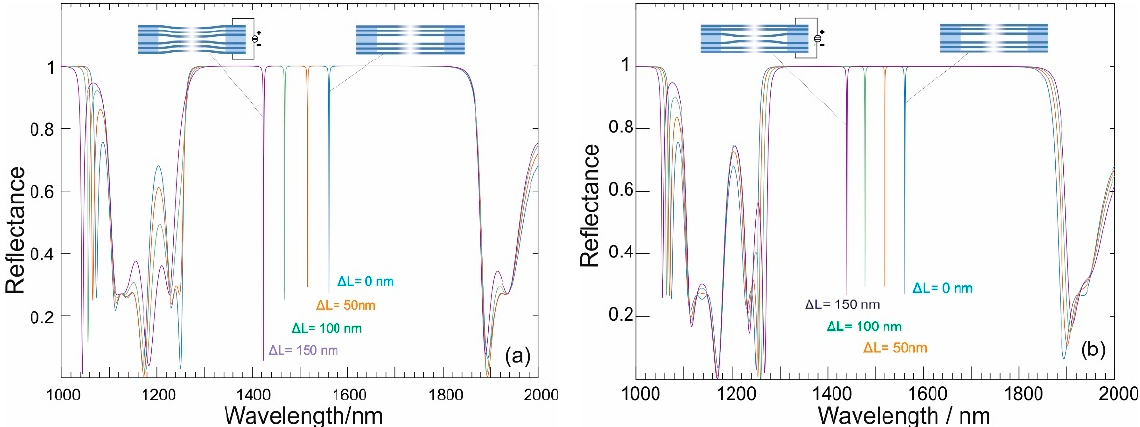
Figure 18. Electrostatic MEMS tuning of InP multiple air-gap filters, ( a ) actuating all membranes of the DBRs and ( b ) actuating only the two central membranes.